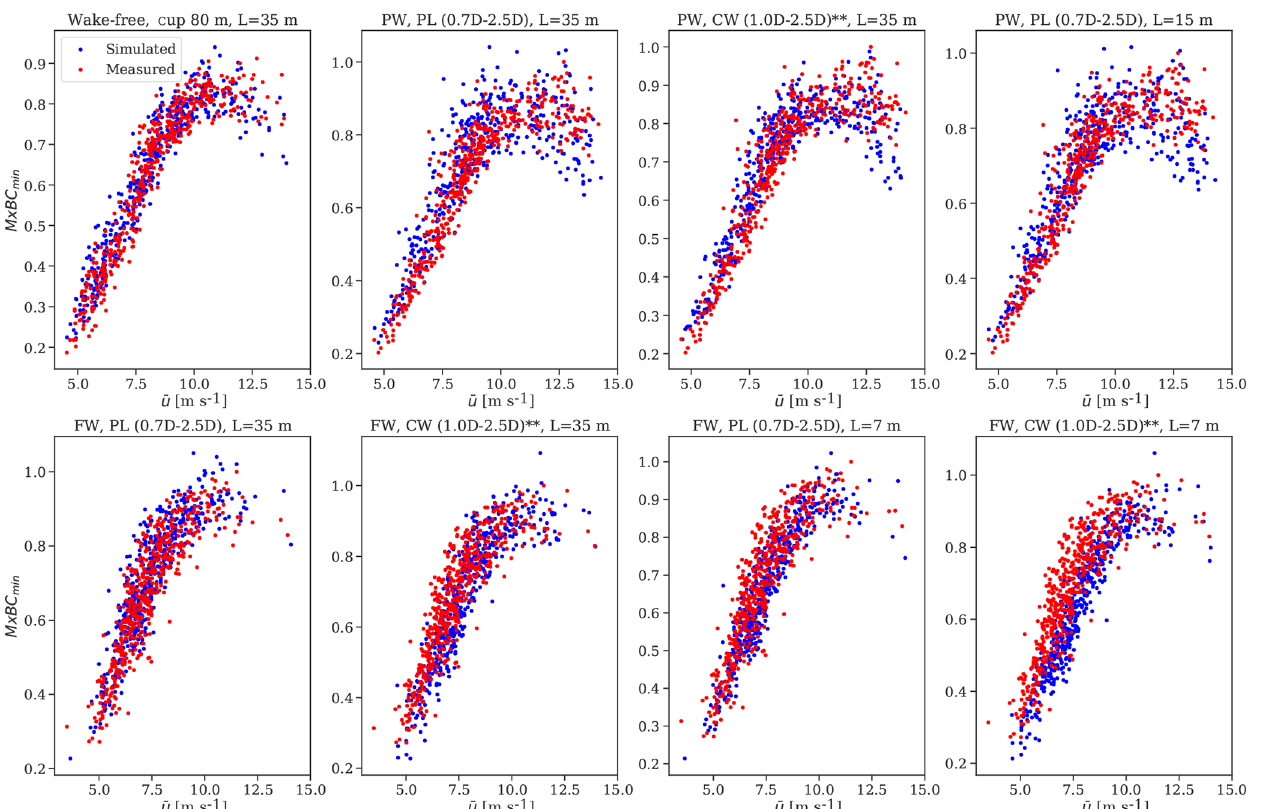
Figure C3. Scatter plots of the normalized measured and predicted extreme flapwise bending moment at the blade-root realizations used in the